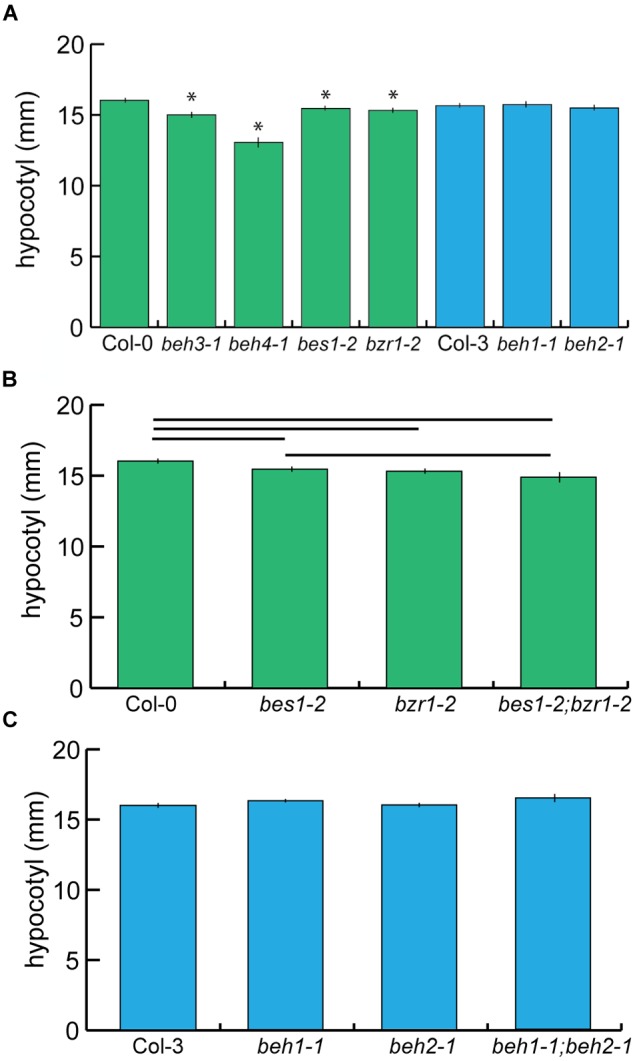
The BZR/BEH family encodes genes with similar effects on hypocotyl length. (A) Seedlings were grown for seven days in the dark, and hypocotyls were measured. beh3-1, beh4-1, bes1-2, bzr1-2 hypocotyls were significantly shorter than those of wild-type (∗p < 0.0001, linear mixed effects model with genotype as a fixed effect and replicate as a random effect). (B) The phenotype of the bes1-2;bzr1-2 double mutant suggests that BZR1 is epistatic to BES1 because there was no significant difference in hypocotyl length between bes1-2 and bes1-2;bzr1-2. Significant differences (p < 0.05) are displayed by the horizontal bars as determined by linear mixed effect modeling. (C) No significant differences in hypocotyl length were observed for beh1-1 and beh2-1 single mutants, or for the double mutant beh1-1;beh2-1. For (A–C) one representative replicate experiment with standard error of the mean for n > 20 is shown.